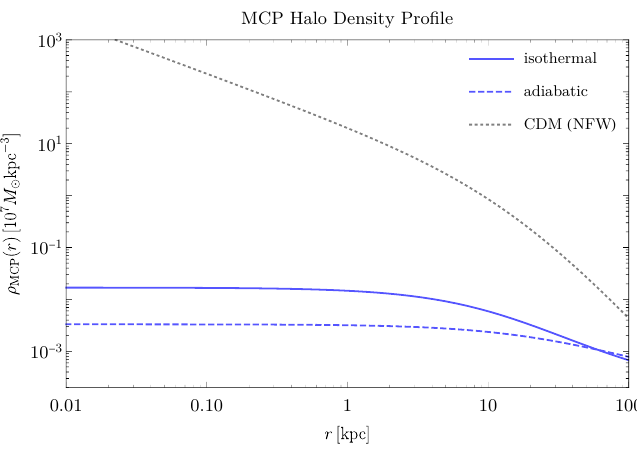
Figure 1 . The mass density ρ MCP ( r ) inferred from hydrostatic equilibrium for an isothermal and adiabatic halo, with ρ CDM ( r ) for comparison. The total fractional MCP mass was set to be f MCP = 5% . The exact forms of both solutions are derived in appendix